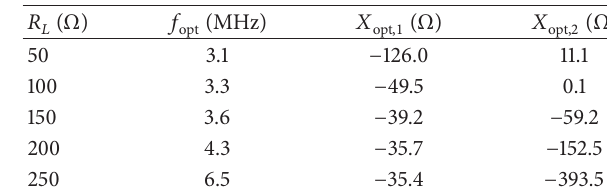
Table 4: Optimal frequencies and values of the compensating components. (The load reactance 𝑋 𝐿 is fixed at 0 Ω .)